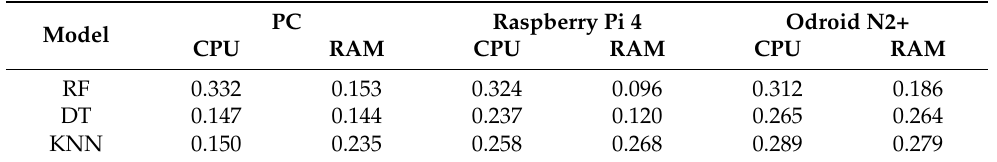
Table 8. CPU Load (%) and Memory utilization (%) of every classification models across all considered hardware